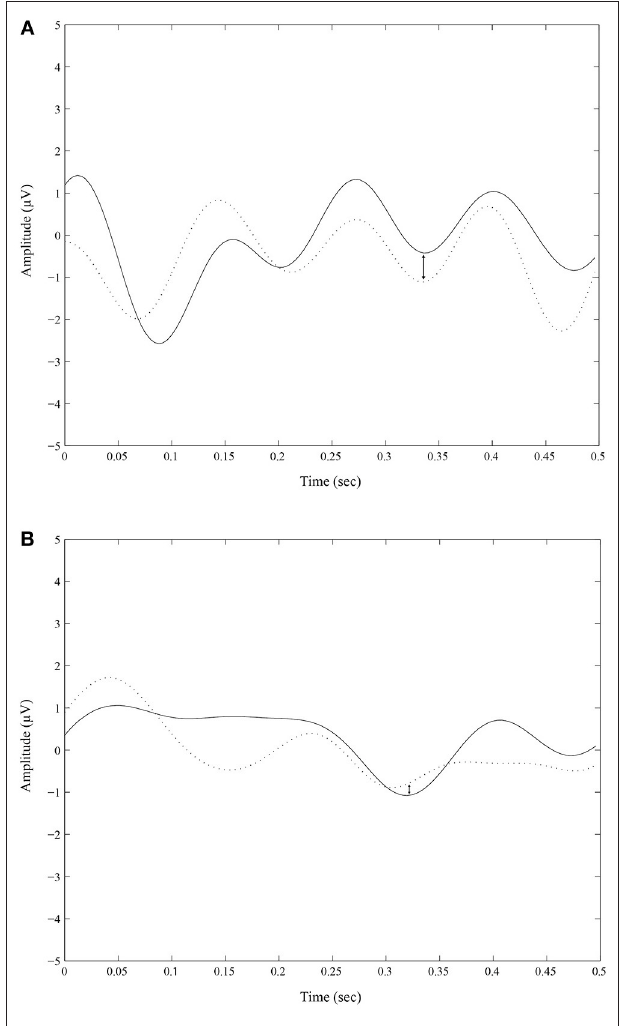
FIGURE 2 | ERP traces for a participant with a high number vs. a low number of phonological choices. Experimental (solid line) vs. control (dotted line) N320 amplitudes at the mid-left of the brain (average of F P1 , F 3 , F Z , C Z , T 3 , T 5 , P Z , and P 3 electrodes) (A) for a participant with a high net number (4) of phonological choices and (B) for a participant with a low net number ( − 7) of phonological choices (right). The N320 waves are